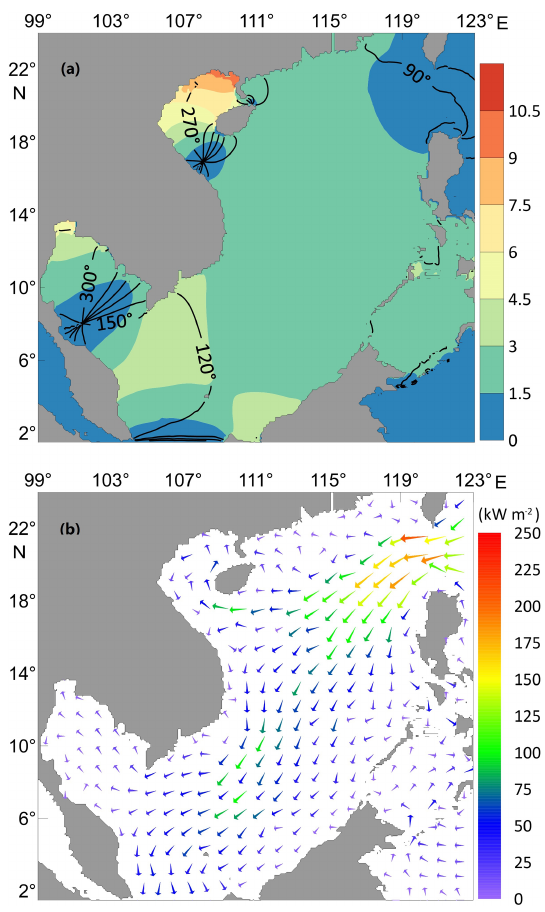
Figure 4. (a) Distribution of amplitude gain (color) and phase change (lines in degrees) for the frequency of 0.99 cycles per day; (b) corresponding energy flux density